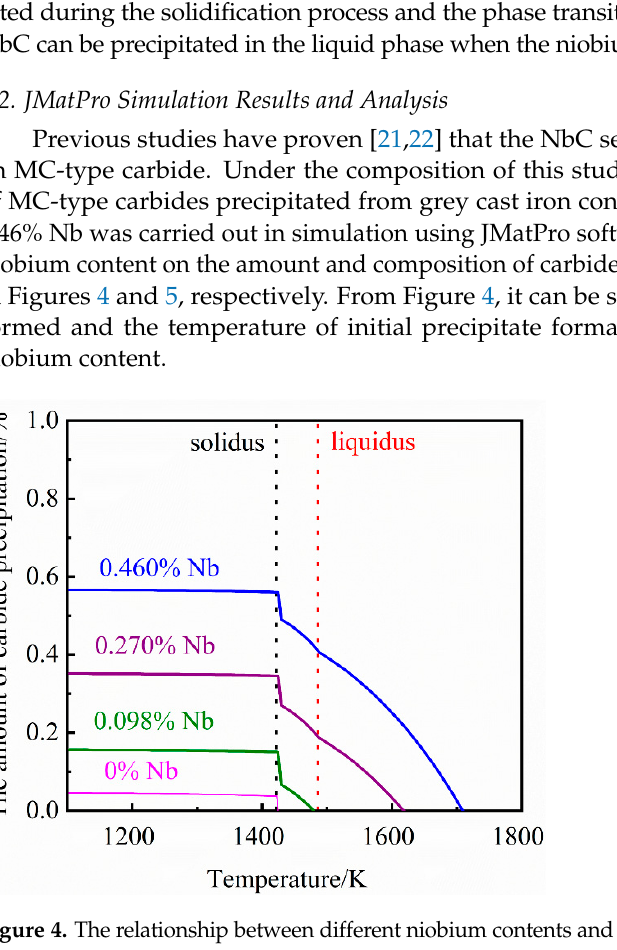
Figure 3. The solubility product curves of NbC in the solid phase.